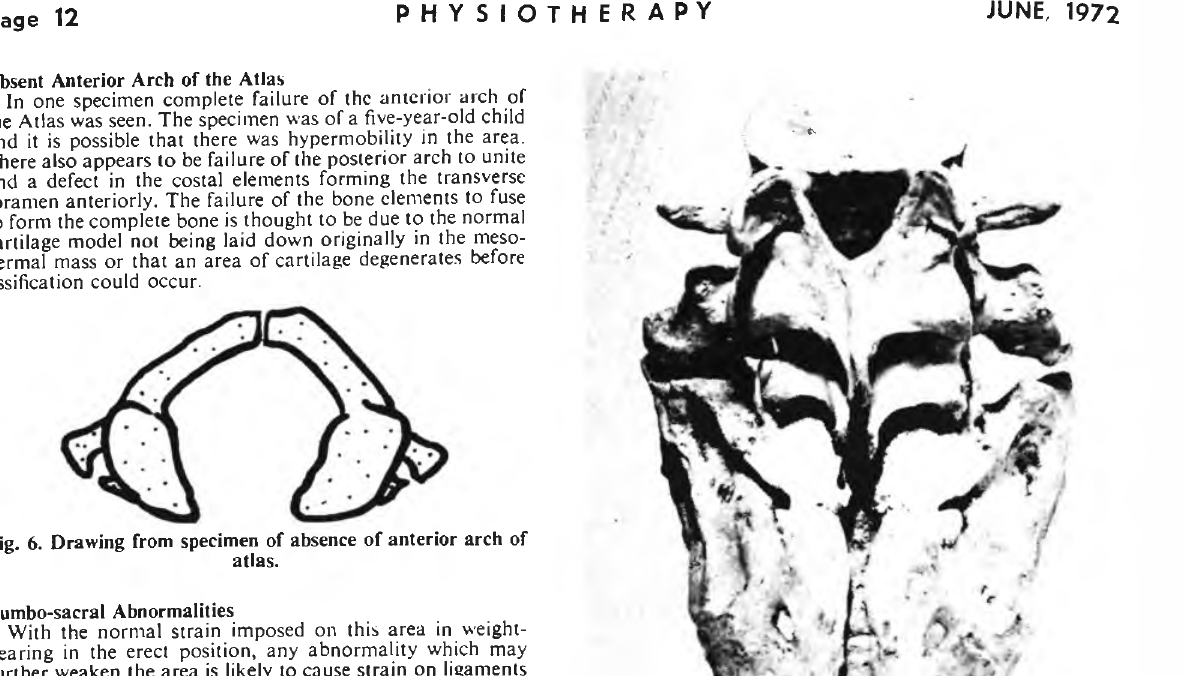
Fig. 6. Drawing from specimen of absence of anterior arch of atlas.